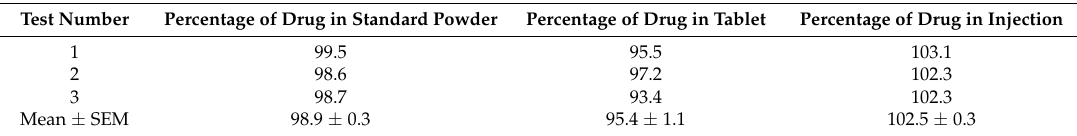
Table 3. Percentage of verapamil measured by the designed method in standard powder, commercially available tablets and